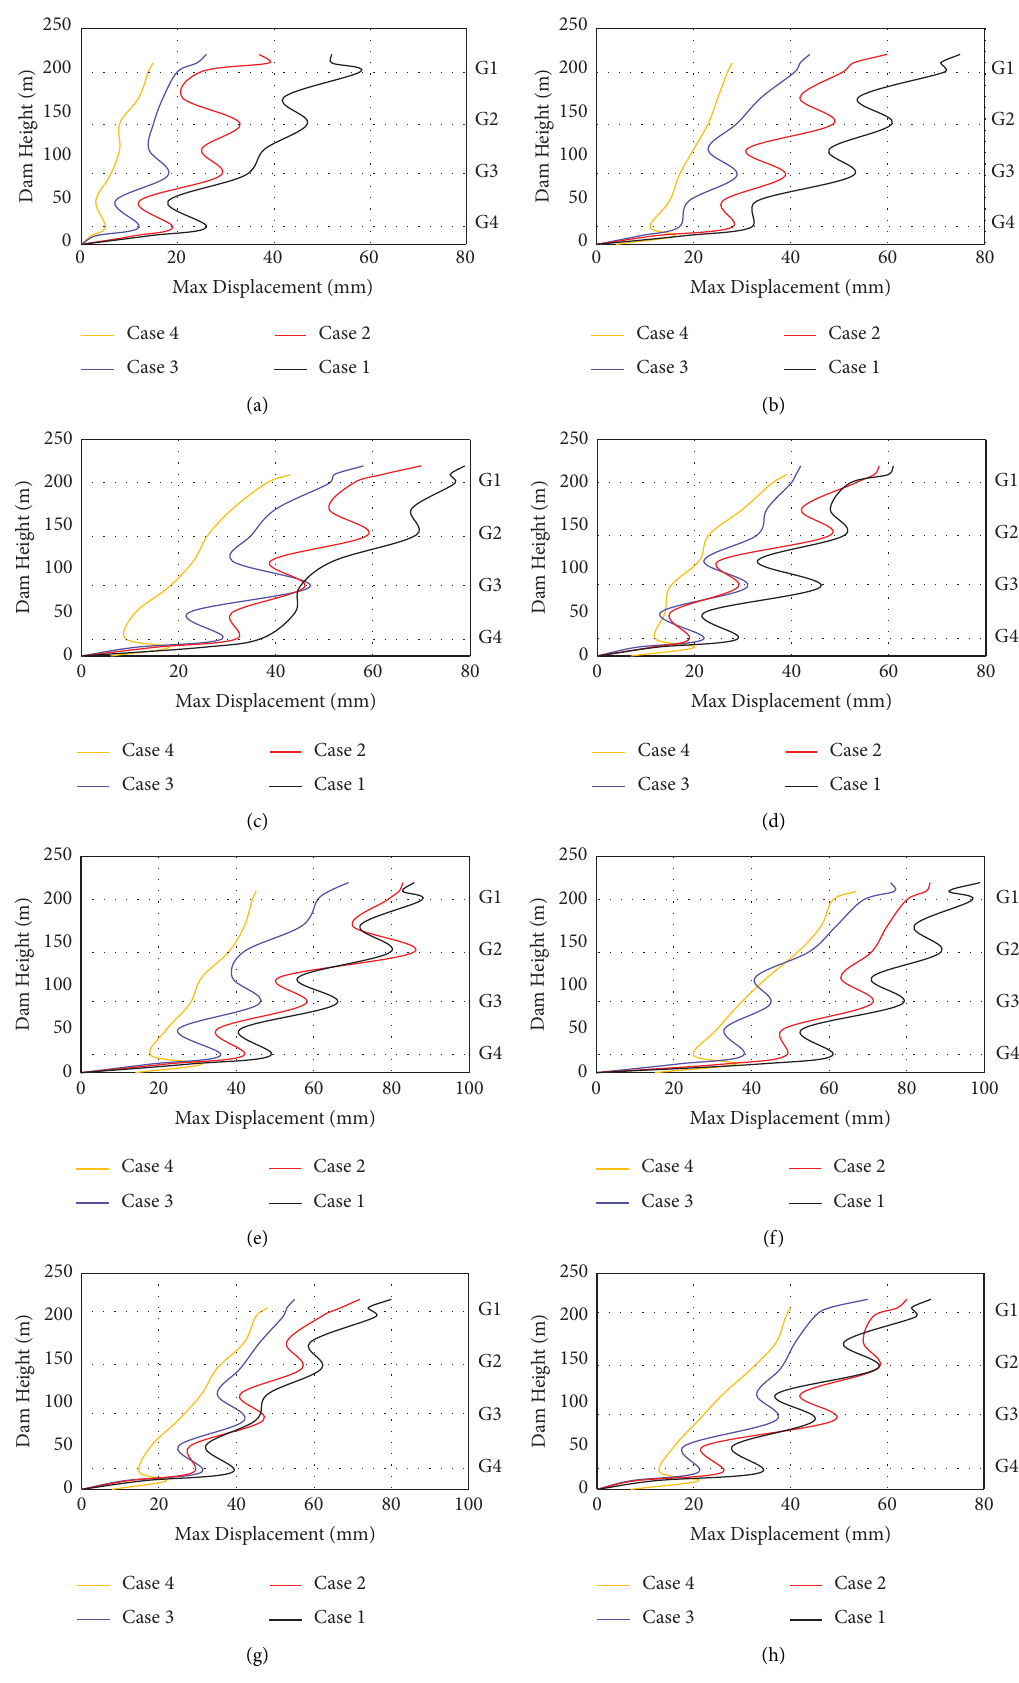
Figure 9: Earthquake displacement results of Ermenek arch dam for EQ1–EQ8 earthquakes: (a) EQ1, (b) EQ2, (c) EQ3, (d) EQ4, (e) EQ5, (f) EQ6, (g) EQ7, and (h)